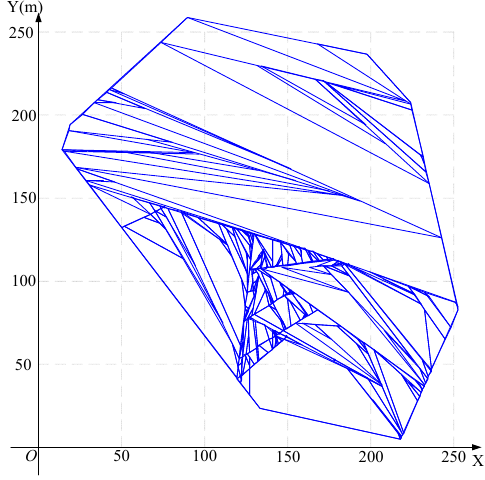
Figure 9. Dividing the feasible region into pieces for the 20 -node network.